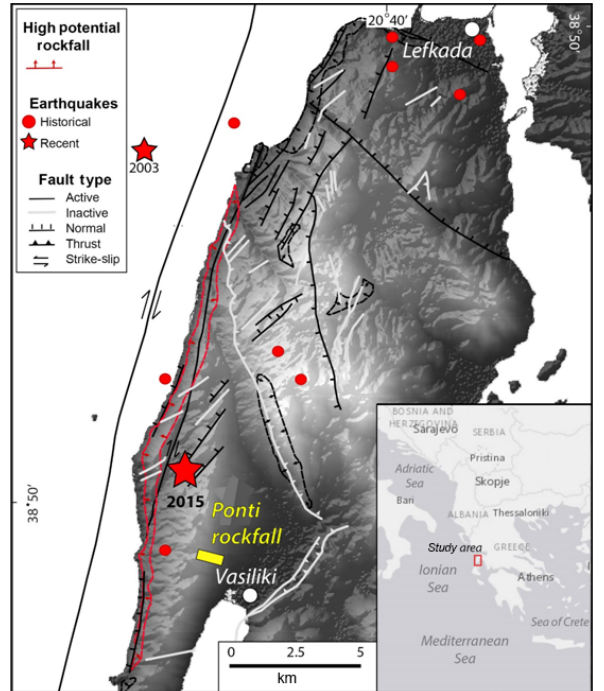
Figure 1. Map of Lefkada island, Greece, with the location of the study site (Ponti) and epicenters of recent earthquakes (stars) in 2003 ( M w = 6.2) and 2015 ( M w = 6.5), as well as historical ones (circles). The map also shows faults and high potential rockfall ar- eas as identified by Rondoyanni et al. (2007).